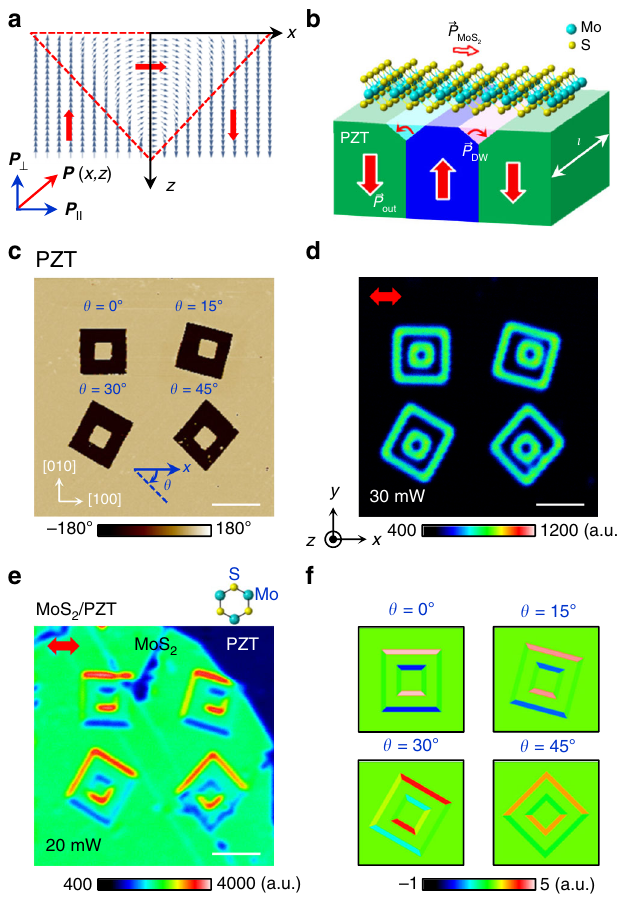
Fig. 3 Effect of polar alignment on the re fl ected SHG response. a , b Schematics of a a fl ux-closure domain (boundary outlined by red dashed lines) at ferroelectric surface above a 180° DW and b the polar alignment at the 1L MoS 2 /PZT interface. The arrows mark the local polarization orientation. c PFM phase image of square domains written on PZT along different angle θ , with the corresponding SHG images taken d before and e after a 1L MoS 2 transferred on top. The excitation laser power is labeled on the plot. The red arrows mark the incident light polarization. There is no analyzer applied. The scale bars are 3 μ m. f Simulated SHG amplitude at 1L MoS 2 /PZT interface for the same domain structures in c – e . The crystalline orientations of PZT and MoS 2 and the laboratory coordinate system are shown as